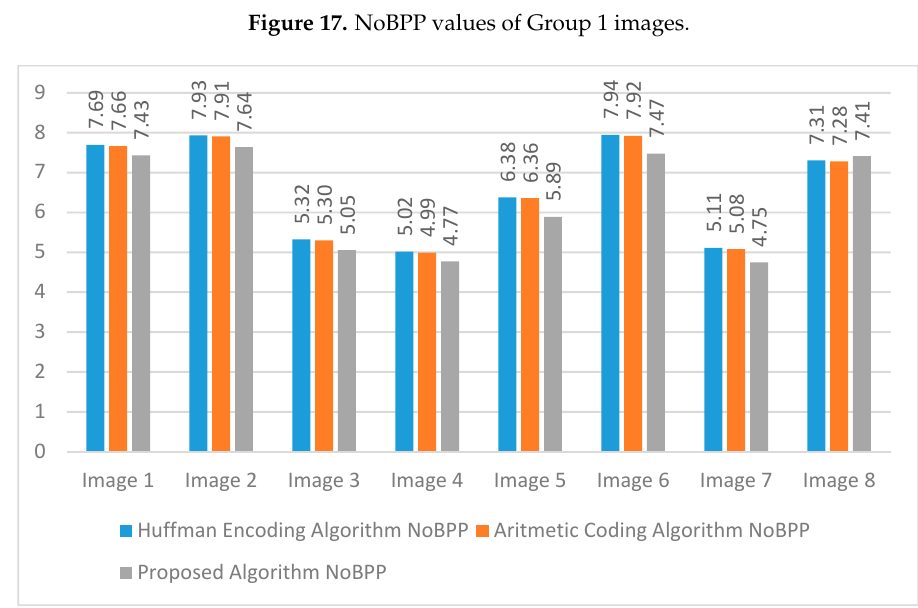
Figure 18. NoBPP values of Group 2 images.